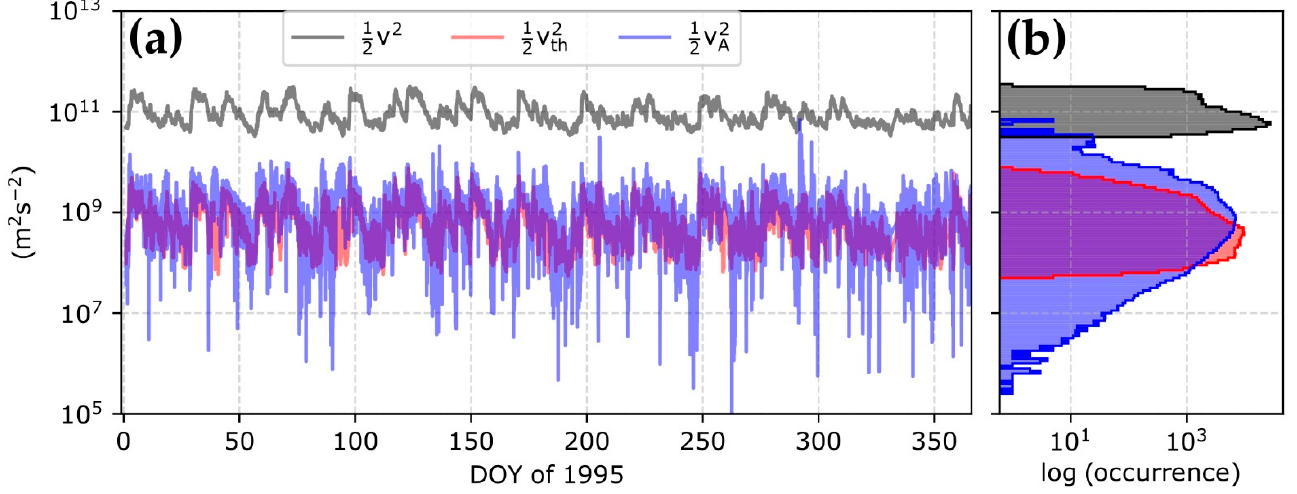
v 2 , (red) 1 v 2 v 2 , and (blue) 1 terms calculated for solar wind protons at ~1 au during 1995, and A 2 2 2 th (cid:3049) (cid:3118) , (red) (cid:3117) (cid:3049) (cid:3178)(cid:3166)(cid:3118) , and (blue) (cid:3117) (cid:3049) (cid:3133)(cid:3118) terms calculated for solar wind protons at ~1 au during 1995, and ( b ) (cid:3118) (cid:3118) (cid:3118) v 2 , is almost always larger than the other 2 (cid:3049) (cid:3118) , is almost always larger than the other two. (cid:3118)